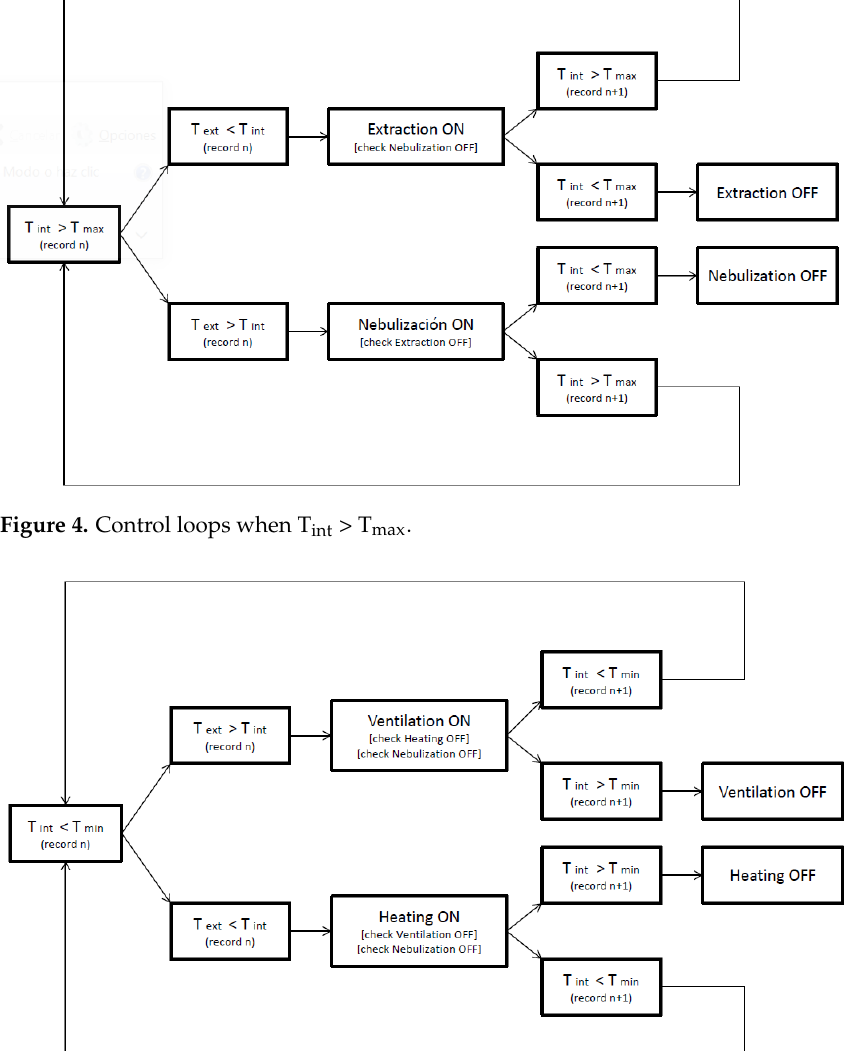
Figure 3. Block diagram of the general operation of the prototype.